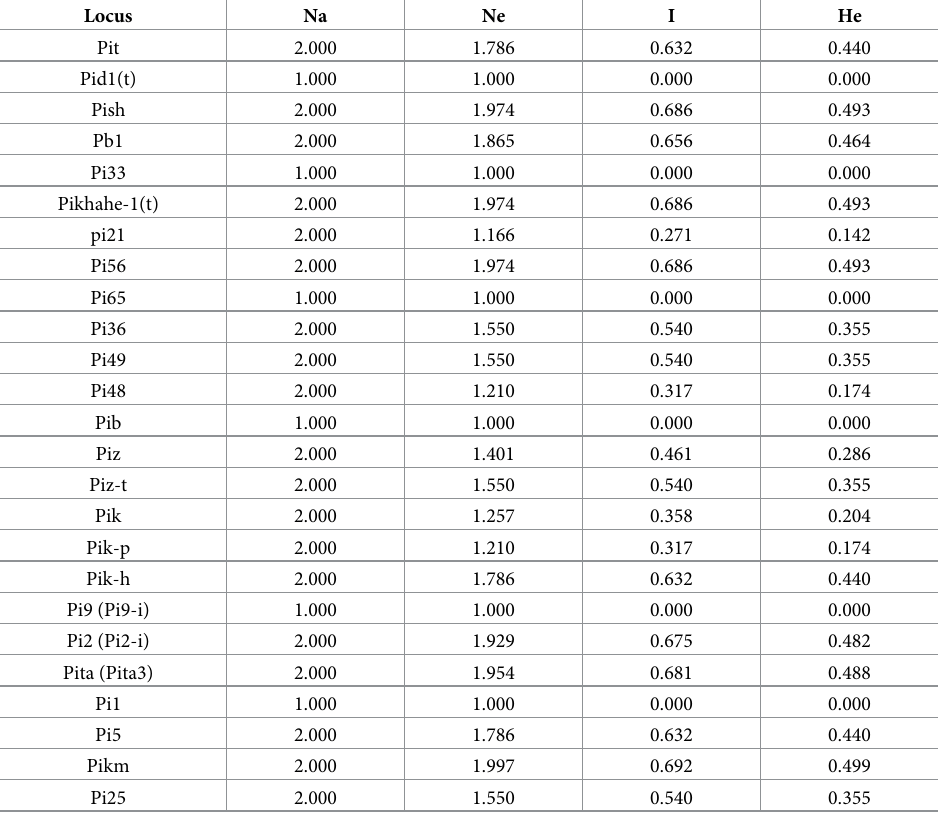
Table 4. Analysis of the number of alleles, Shannon’s Information Index, observed and expected Heterozygosity. Locus Na Ne I He